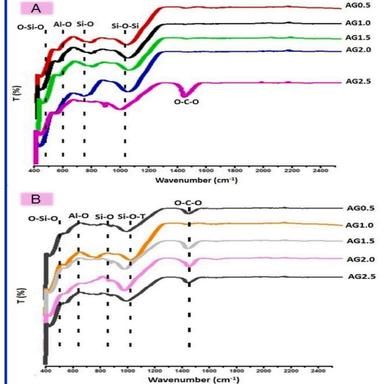
FT-IR spectra of designed geopolymer compositions by varying sodium hydroxide to sodium silicate ratios. (A) FT-IR graph of dry geopolymer precursor mixes and (B) FT-IR graph of geopolymer coating material.